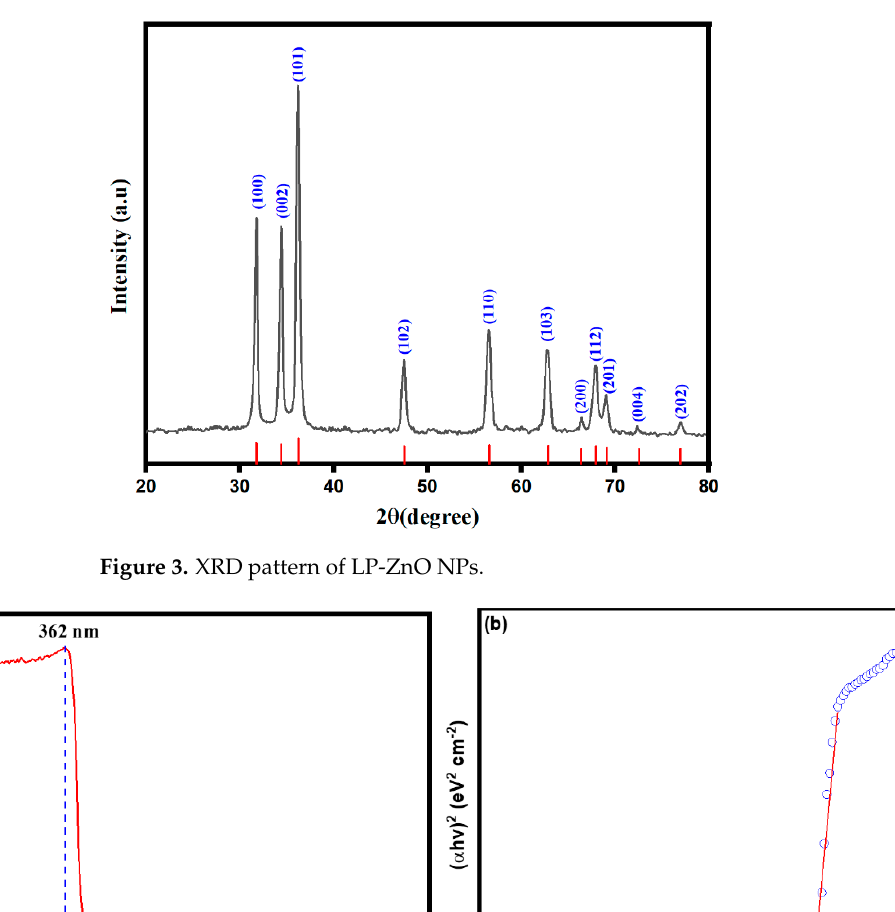
Figure 3. XRD pattern of LP-ZnO NPs.